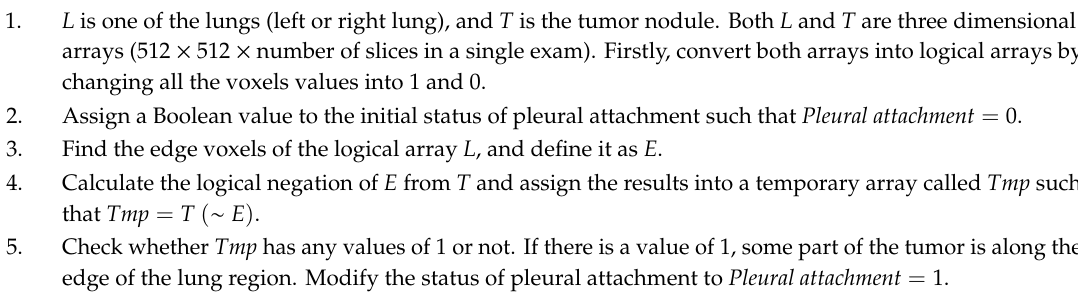
Algorithm 2. Pleural attachment